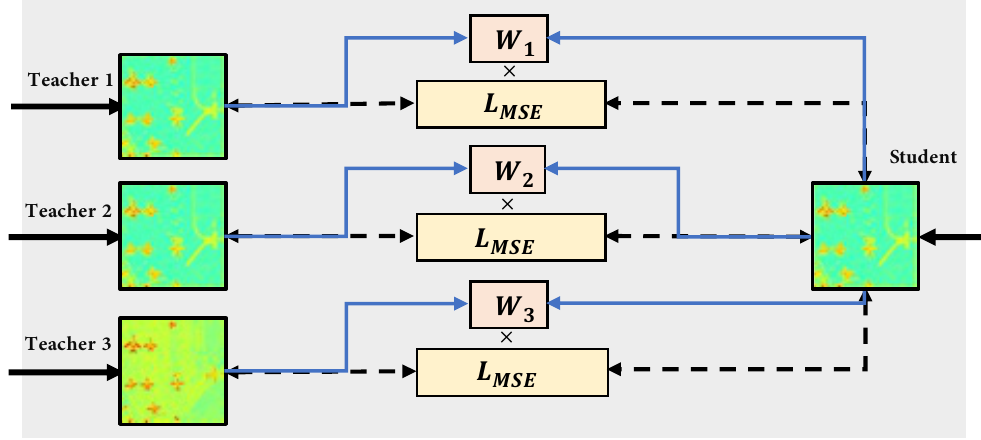
Figure 5. Adaptive dense multi-teacher distillation strategy. It is important to note that the weight values can be dynamically adjusted by network learning rather than being fixed. However, since the weight is unbounded, it will increase the possibility of training instability. Therefore, to constrain the value range of each